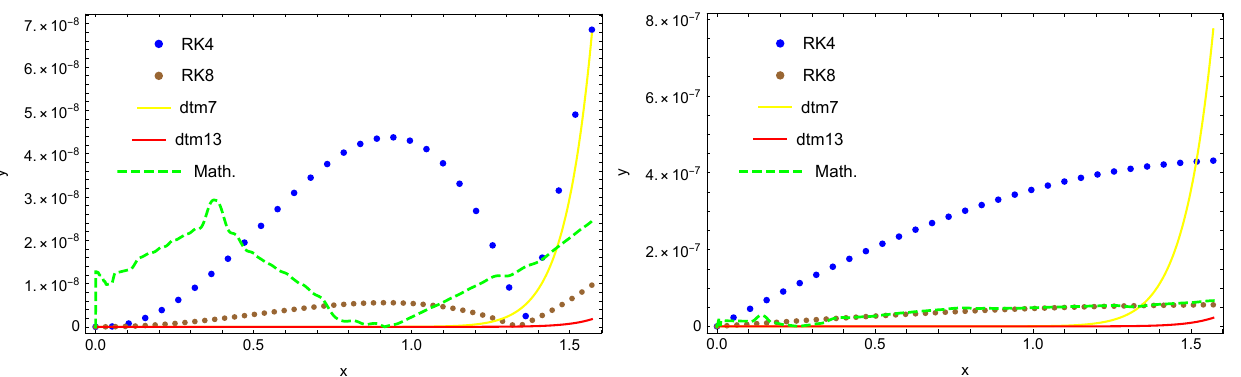
Figure 5. Plot of error ∆ of the approximate